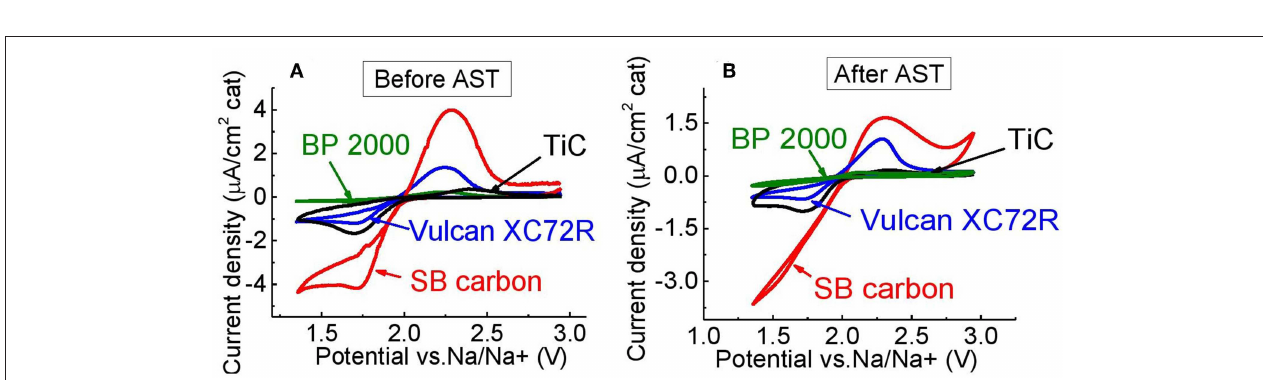
FIGURE 9 | Electrochemical performance of Vulcan XC72R, Black pearls 2000, SB carbon, and TiC, coated on glassy-carbon electrode, (A) before, and (B) after AST, in PEGDME/0.25M NaOTf (Scan rate 5 mV/s).